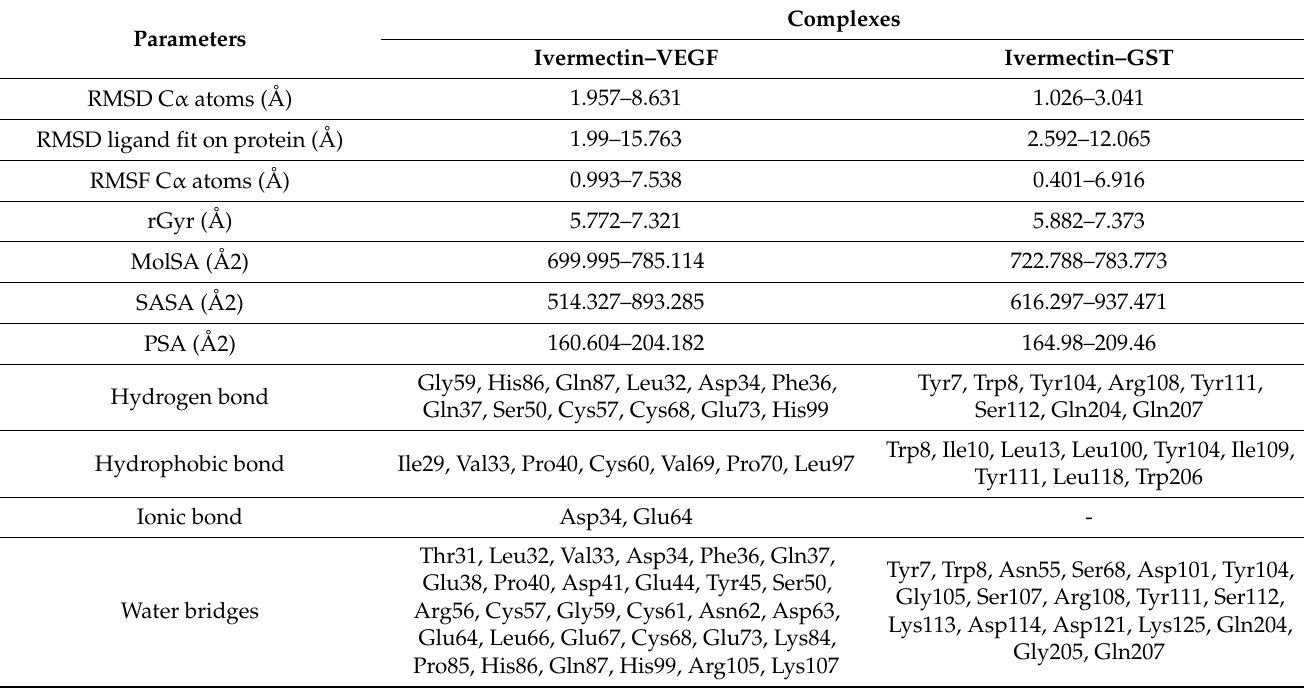
Figure 5. Conformational changes during MD simulation. ( A , B ) The plots showing RMSD values of ivermectin–VEGF and ivermectin–GST complexes during 100 ns MD simulation. ( C , D ) The plots showing RMSF values of ivermectin–VEGF and ivermectin–GST complexes during 100 ns MD simulation. In RMSF plots, the amino acid residues (interacted with the ligand) are shown by green vertical lines, whereas the salmon and cyan rectangles show the alpha helix and beta-strand domains, respectively. Table 2. MD simulation parameters of ivermectin with VEGF and